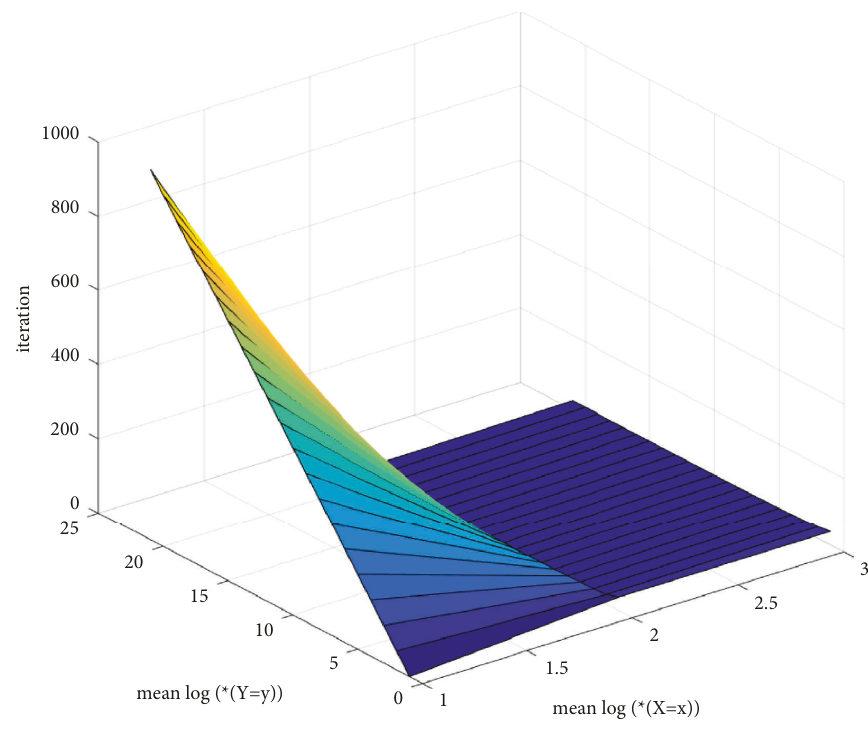
Figure 2: Example convergence graph of neutrosophic fuzzy algorithm.